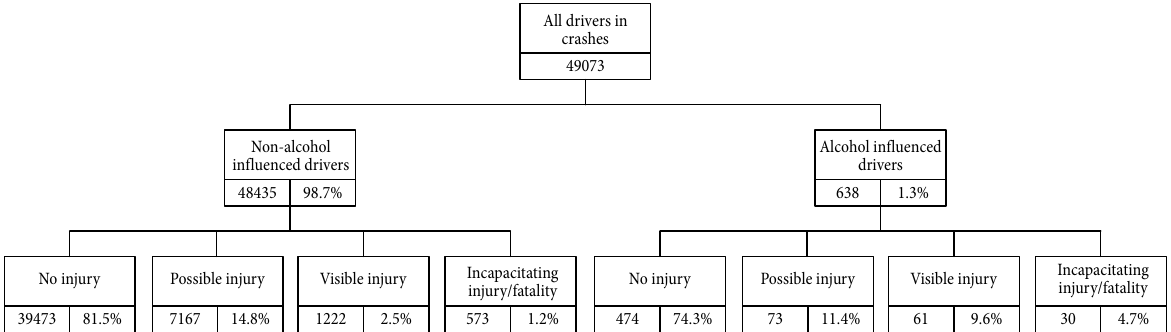
Fig. Intersection-related driver injury severity classification